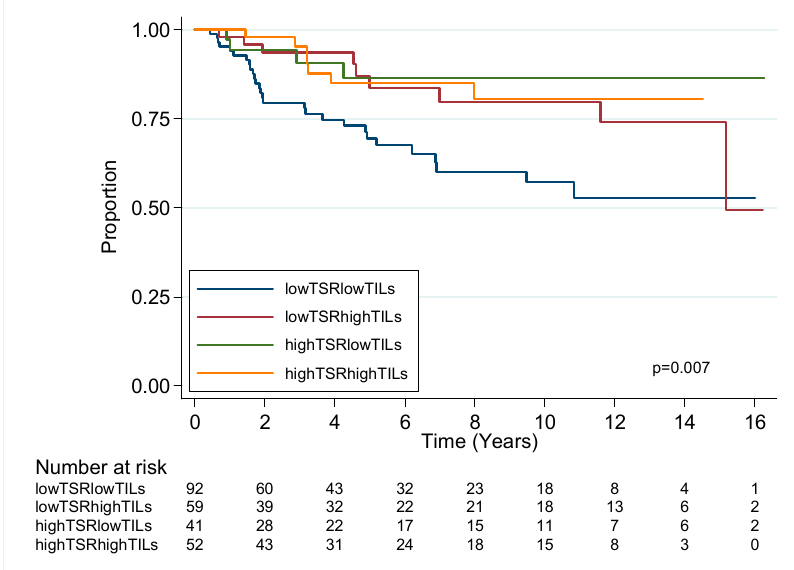
Figure 3. Kaplan–Meier survival estimates for breast cancer specific survival in TNBC stratified by TSR and TSR and TILs.